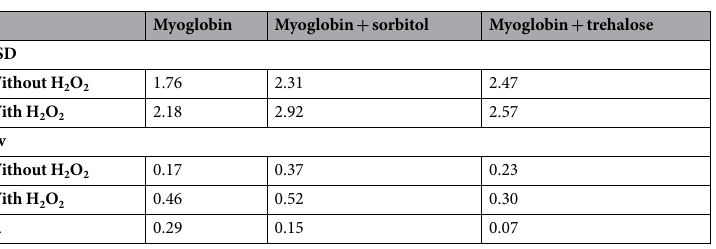
Table 1. Root-mean-square atomic positional deviation (RMSD) and standard deviation of Myoglobin, Myoglobin + sorbitol and +